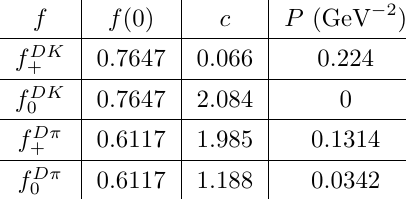
Table 11 . Best (cid:12)t parameters for the form factors (C.21) of D